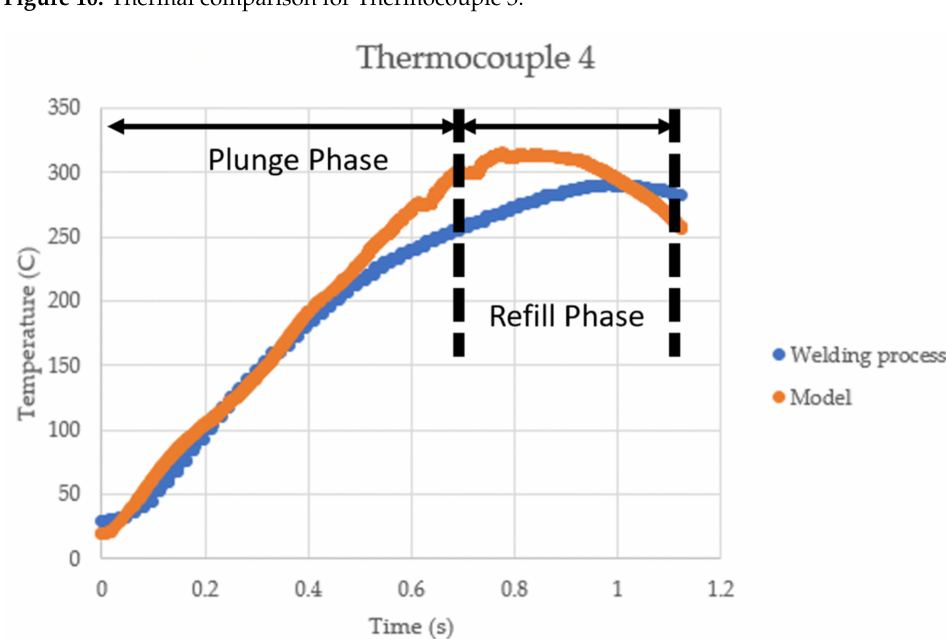
Figure 11. Thermal comparison for Thermocouple 4. The temperature comparison between the experimental validation and the simulation differs by 12% at most for the entire duration of the weld, with most of the predicted temperatures well within 10% of the experiment. The accuracy of the predictions indicates that the heat generation and material flow in the model resemble the welding process. Temperature peaks for the five thermocouples and numerical sensors within the model are displayed in Figure 13. This comparison shows that peak temperatures at each location were within 10% of the measured